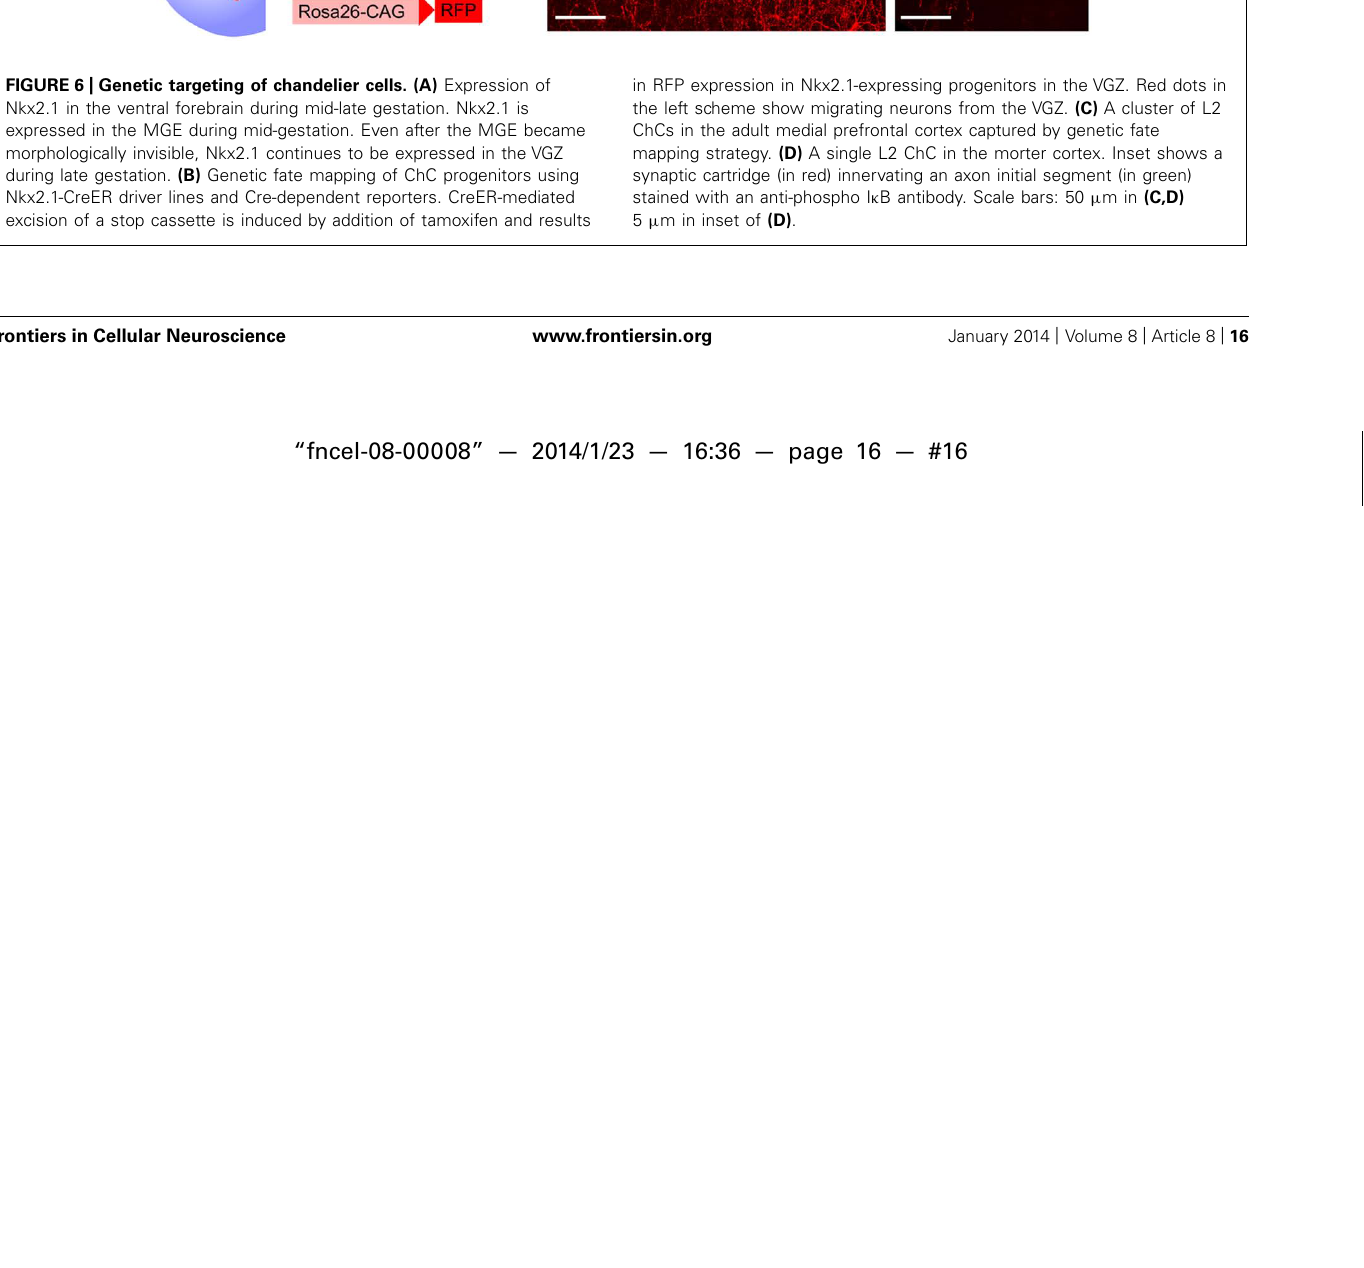
in RFP expression in Nkx2.1-expressing progenitors in the VGZ. Red dots in the left scheme show migrating neurons from the VGZ. (C) A cluster of L2 ChCs in the adult medial prefrontal cortex captured by genetic fate mapping strategy. (D) A single L2 ChC in the morter cortex. Inset shows a synaptic cartridge (in red) innervating an axon initial segment (in green) stained with an anti-phospho I κ B antibody. Scale bars: 50 μ m in (C,D) 5 μ m in inset of (D)